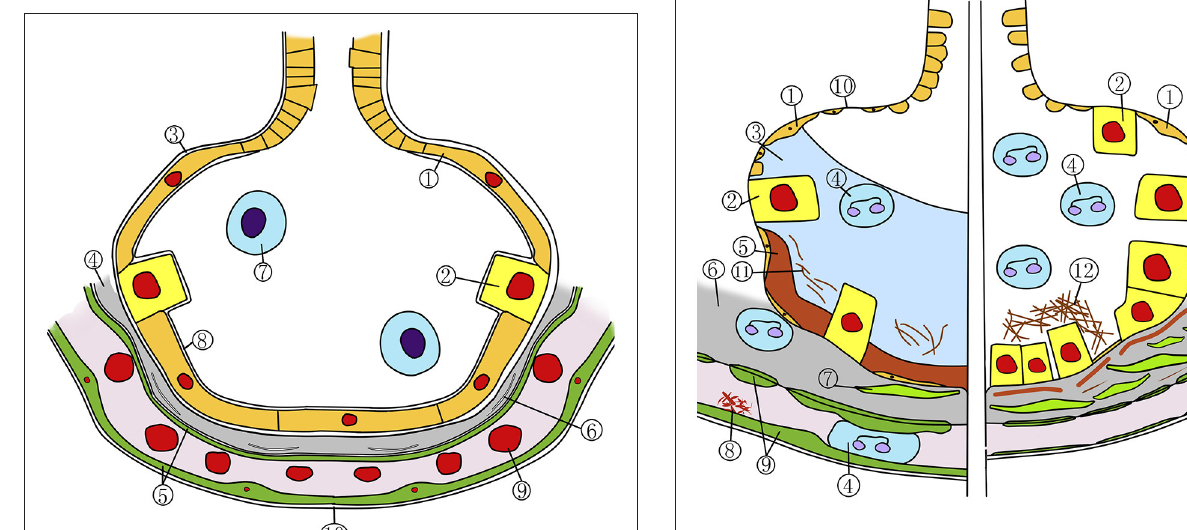
FIGURE 2 | Exsudative stage (left) and proliferative stage (right) in pulmonary oxygen toxicity. 1, type 1 alveolar cell; 2, type 2 alveolar cell; 3, alveolar edema; 4, neutrophil; 5, hyaline membrane; 6, edematous interstitium; 7, fibroblast; 8, fibrin thrombus; 9, swollen capillary endothelial cell; 10, denuded basement membrane; 11, alveolar fibrin formation; 12, collagen fibers deposition; 13, incorporation of hyaline membrane; 14, fibroblastic proliferation; 15, interstitial